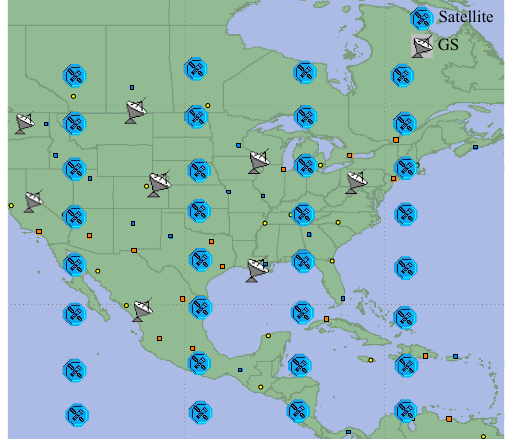
Figure 4. Constellation diagram in the simulation software.